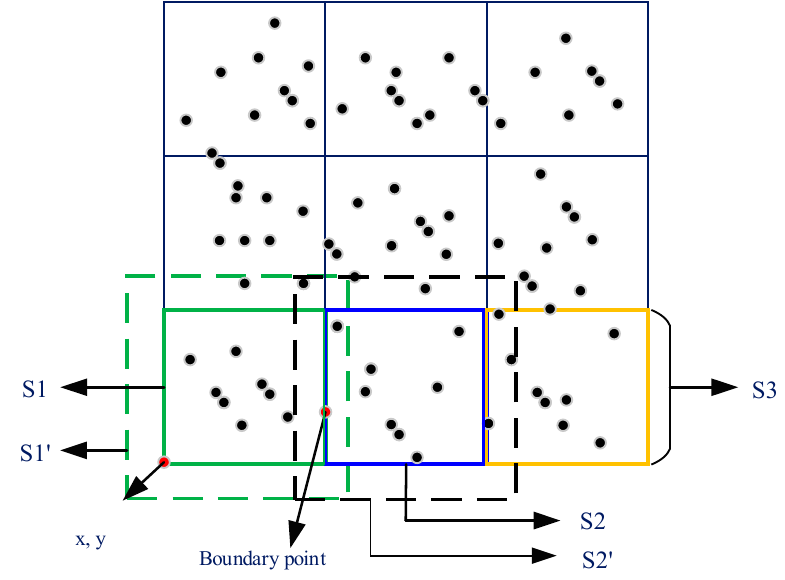
Figure 7. The second phase of data partitioning.